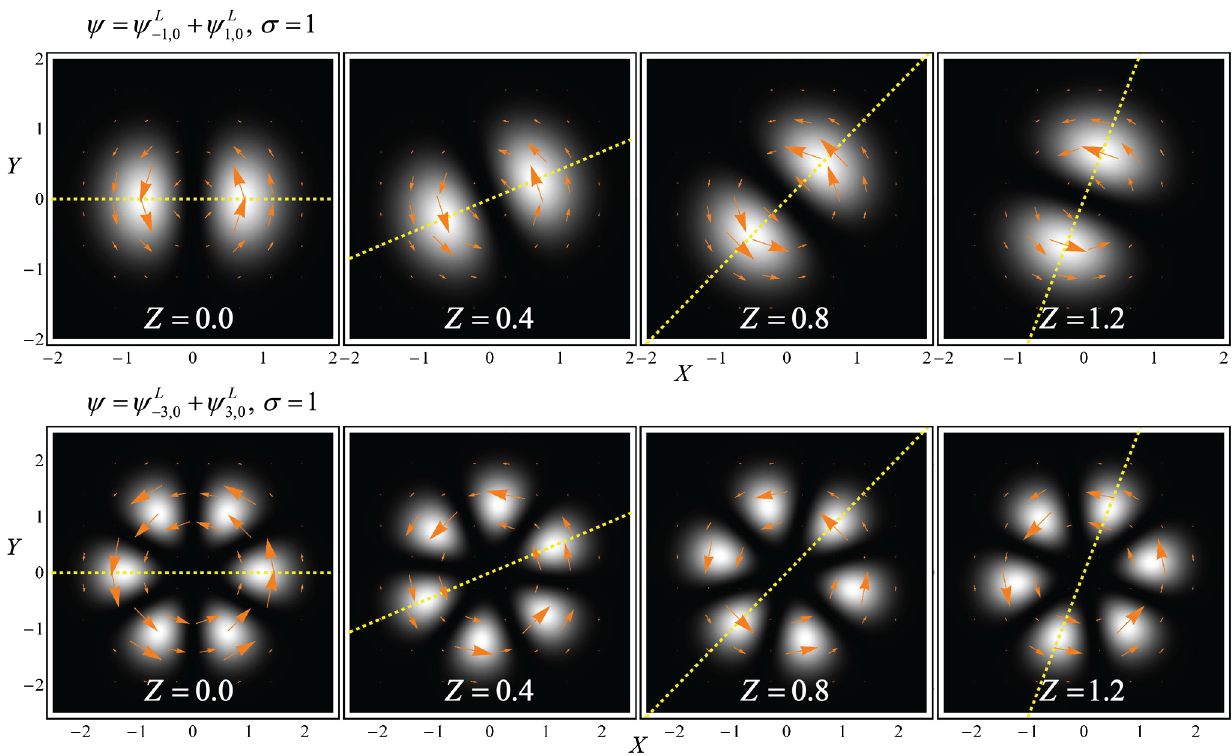
FIG. 6. Evolution of the OAM-balanced superpositions (38) with ‘ ¼ 1 (upper panels) and ‘ ¼ 3 (lower panels) in the magnetic field with (cid:8) ¼ 1 . Probability densities and currents are shown. The rotation on propagation along z , Eq. (39), corresponds to the Larmor frequency j (cid:2) j . The dimensionless coordinates X ¼ x=w